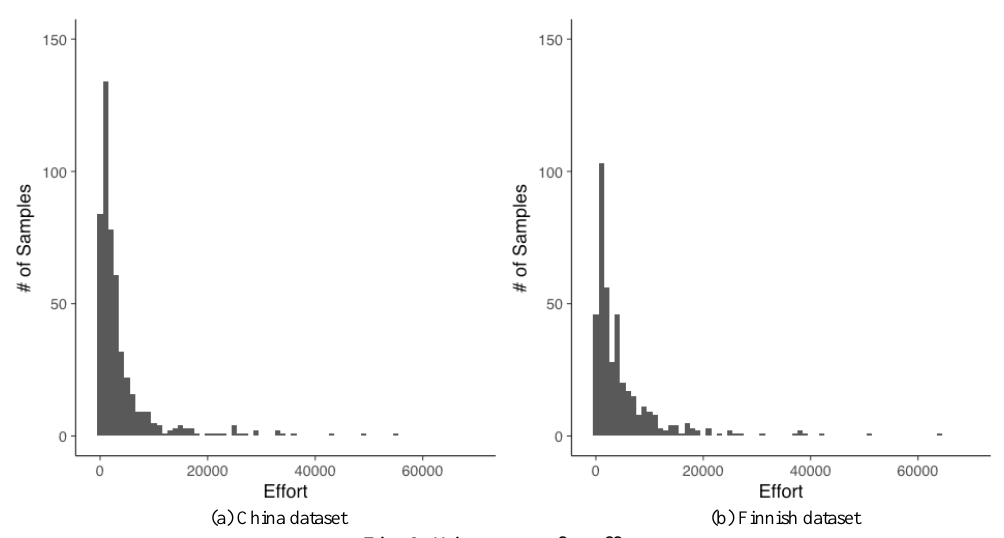
Fig. 3. Histograms for effort